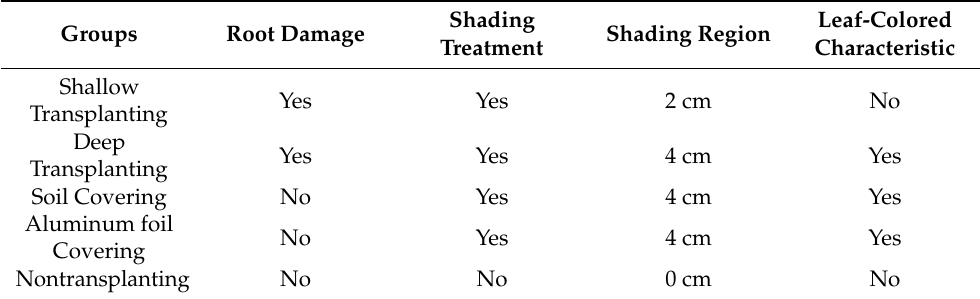
Table 1. Phenotype analysis of zebra leaves occurred under different treatments.